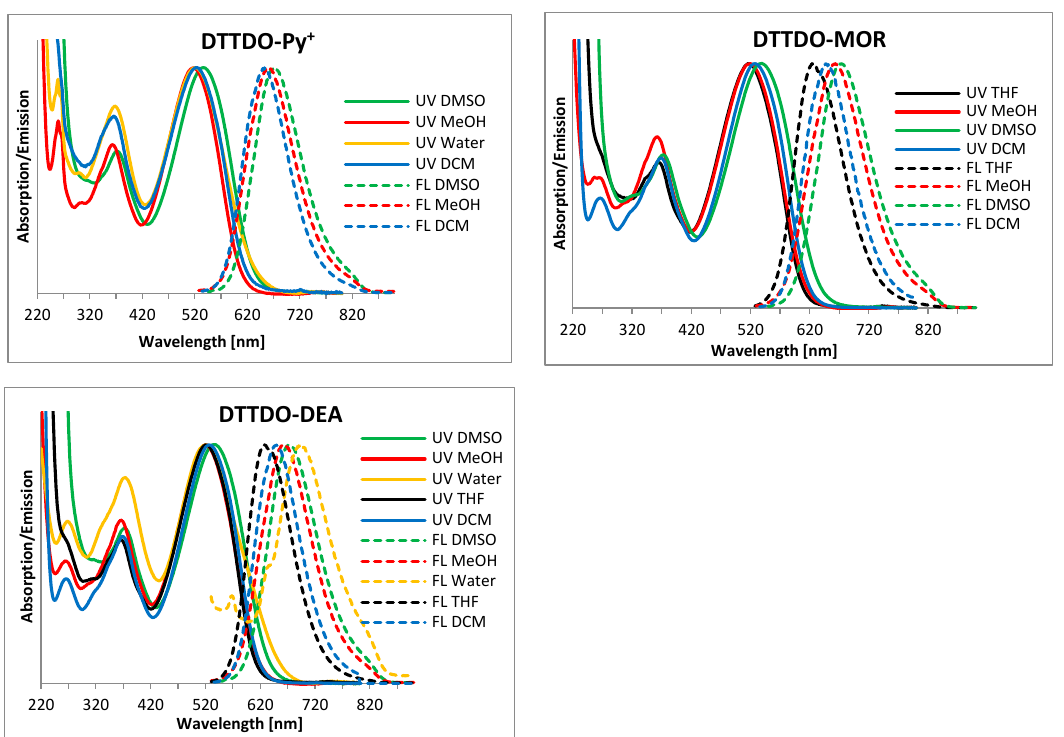
Figure 4. Normalized fluorescence (dotted line) and UV-VIS (solid line) spectra of DTTDO derivatives in different solvents.